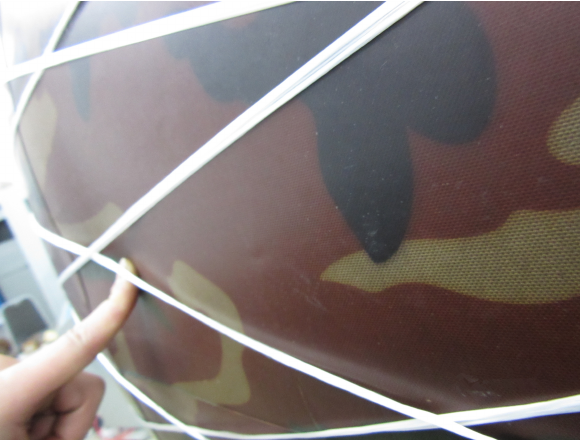
Figure 11: Results of winding linear